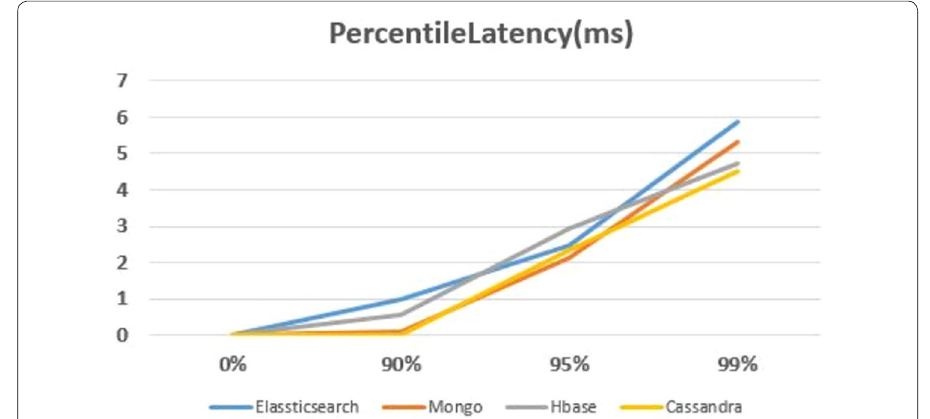
Fig. 9 Percentile-latency of Elasticsearch, MongoDB, Hbase and Cassandra